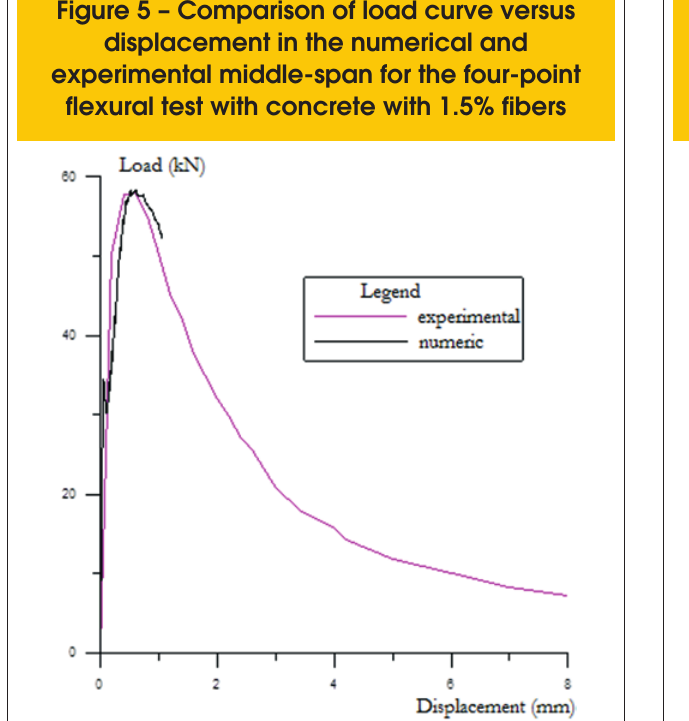
Figure 6 – Comparison of load curve versus displacement in the numerical and experimental middle-span for the four-point flexural test with concrete with 2.0%